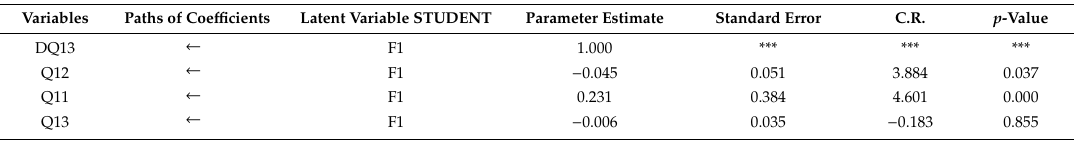
Table 8. Confirmatory factor analysis of